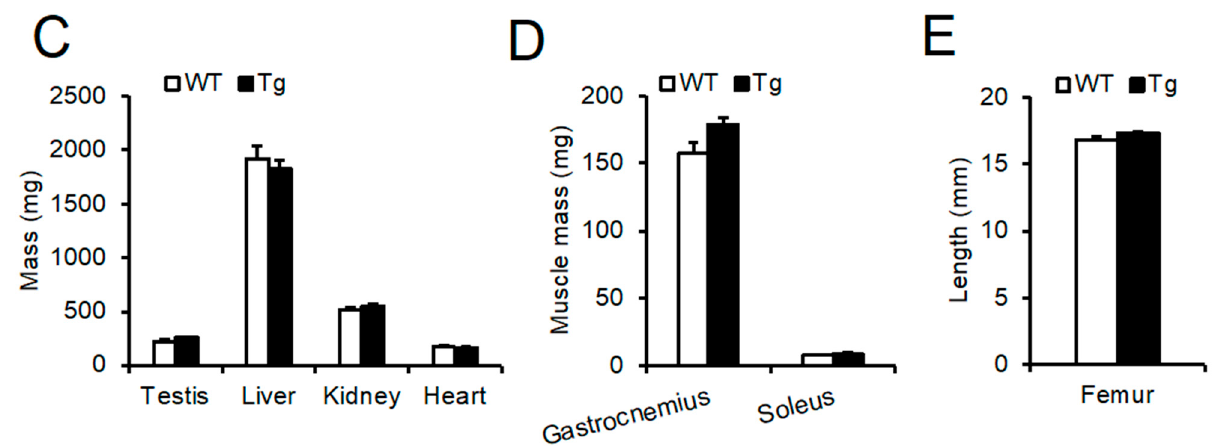
Figure 2. Phenotypic analysis of body mass, food intake, and peripheral tissues of the 13-line of Npgl Tg mice. ( A ) Weekly body mass changes ( left ) and body mass ( right ) at 26 weeks of age of WT and Npgl Tg mice. ( B ) Weekly food intake ( left ) and cumulative food intake ( right ) from 15 to 26 weeks of age. ( C ) The masses of the testis, liver, kidney, and heart. ( D ) The masses of the gastrocnemius and soleus muscles. ( E ) The length of the femur as an index of body length. Statistical analyses were performed using two-way repeated measures ANOVA followed by Bonferroni’s test (left of ( A , B )) or Mann–Whitney U test (right of ( A , B ), and ( C – E )). Each value represents the mean ± SEM ( n = 5–8). Asterisks indicate statistically significant differences (* p < 0.05). Npgl , neurosecretory protein GL; WT, wild-type; Tg, transgenic.